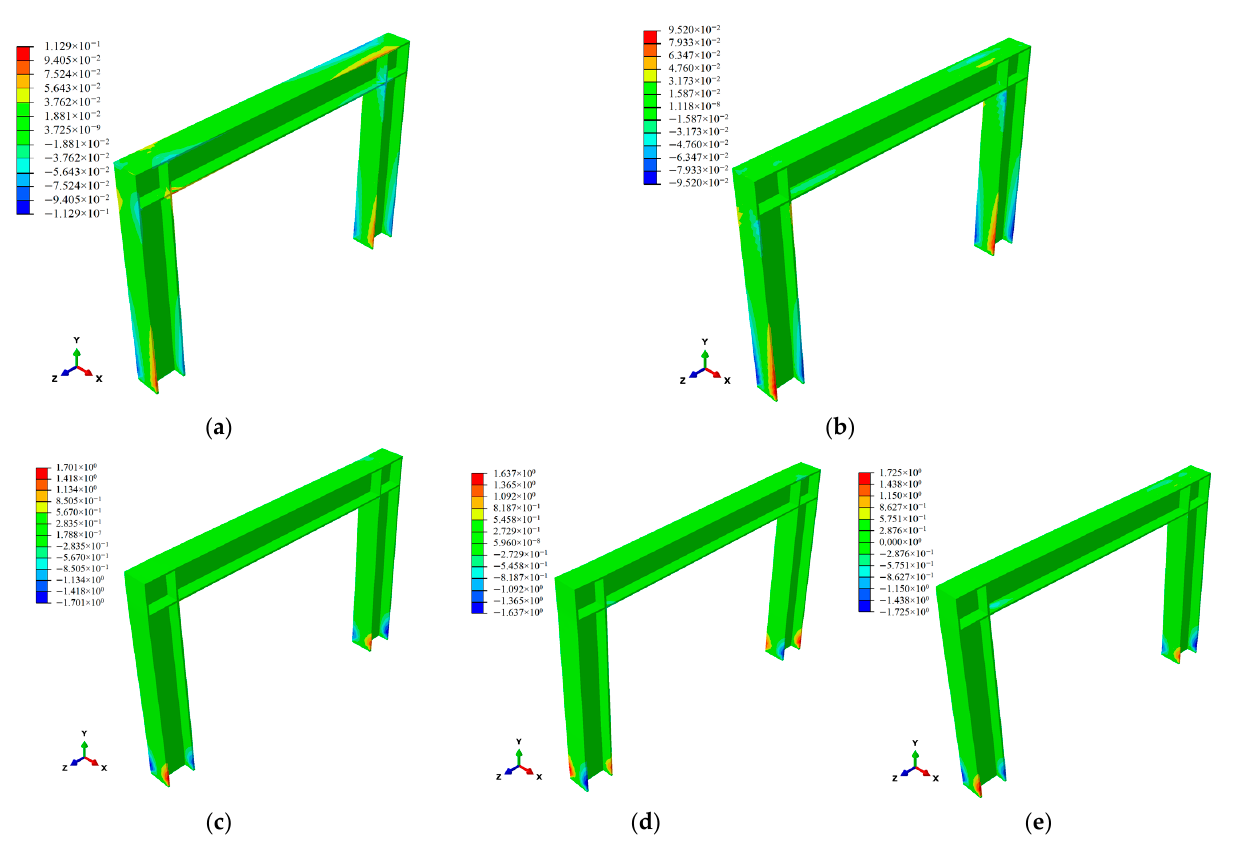
Figure 20. Out-of-plane deformation of steel plate of FRAME and FRAME-X under cyclic loading: ( a ) FRAME at a drift ratio of 0.005; ( b ) FRAME-X at a drift ratio of 0.005; ( c ) FRAME at a drift ratio of 0.025 in push direction of the loading end; ( d ) FRAME at a drift ratio of 0.025 in pull direction of the loading end; ( e ) FRAME-X at a drift ratio of 0.025.